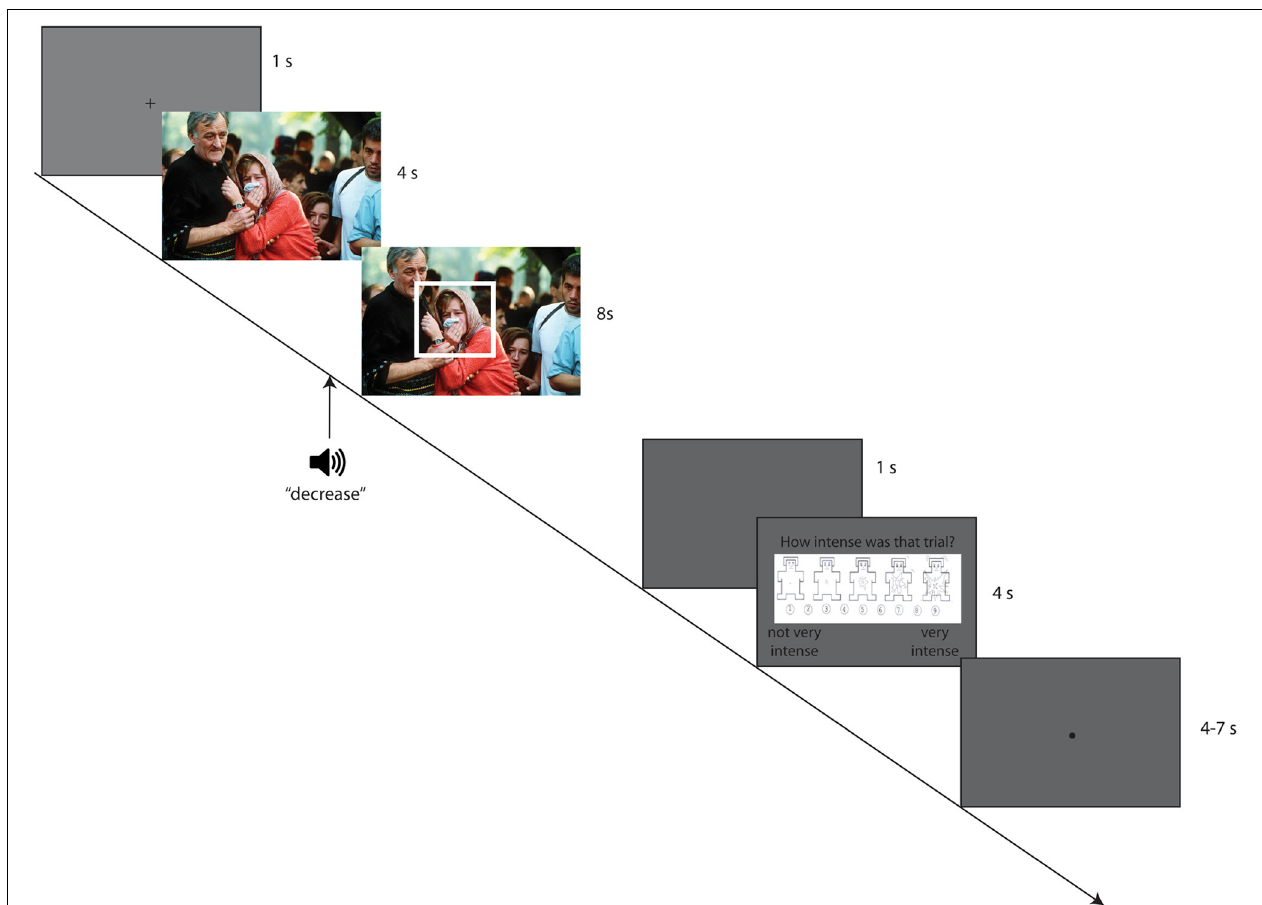
FIGURE 1 | Trial structure. Participants first saw a fixation cross for 1s, followed by a picture for a total of 12s. Three seconds after picture onset, participants heard the cognitive reappraisal (CR) instruction for that trial, if applicable (in this case, “decrease”). One second thereafter, a box directed them to look in an arousing or nonarousing area of the picture, if applicable (in this case, the box is directing gaze to an arousing area). After the 8-s